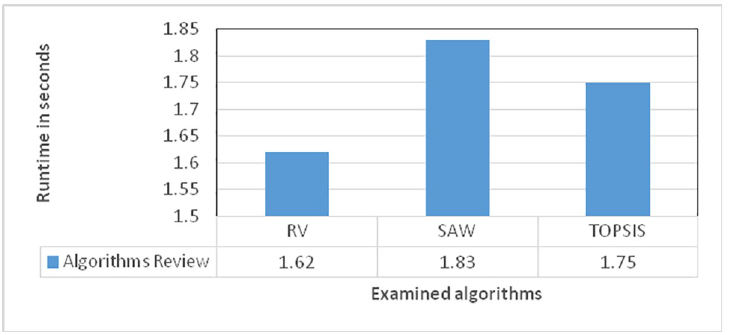
Fig 6. A comparison of the proposed algorithm and the other